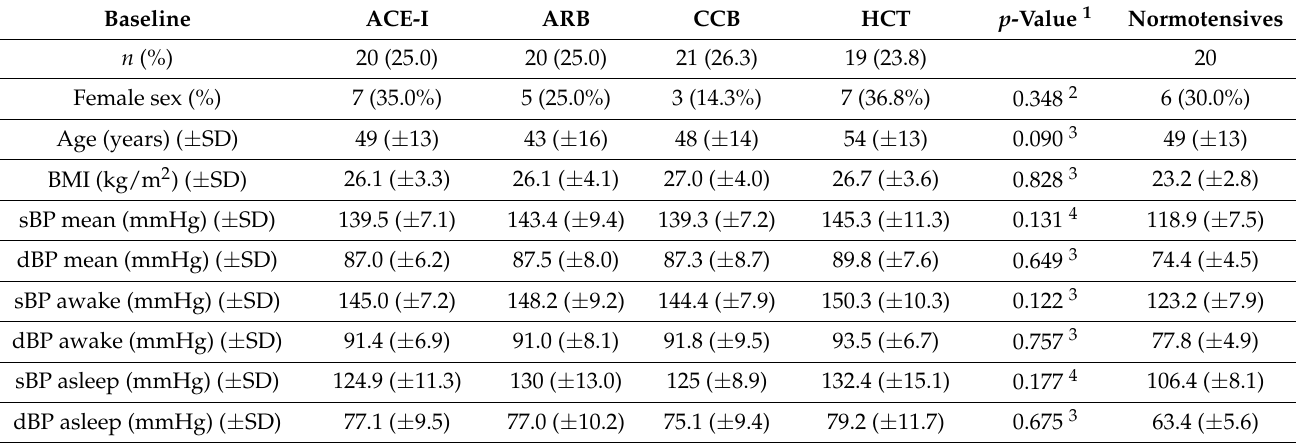
Table 1. Baseline characteristics in patients randomized for each drug (perindopril (ACE-I), olmesartan (ARB), amlodipine (CCB) or hydrochlorothiazide (HCT)) before treatment initiation and normotensive controls.